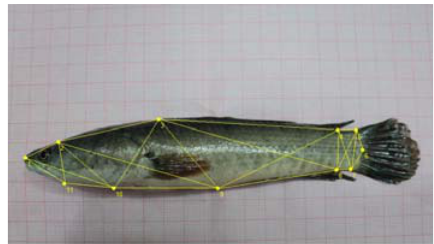
Figure 1: Location of 11 morphometric landmarks for constructing the truss network system on Channa punctatus .